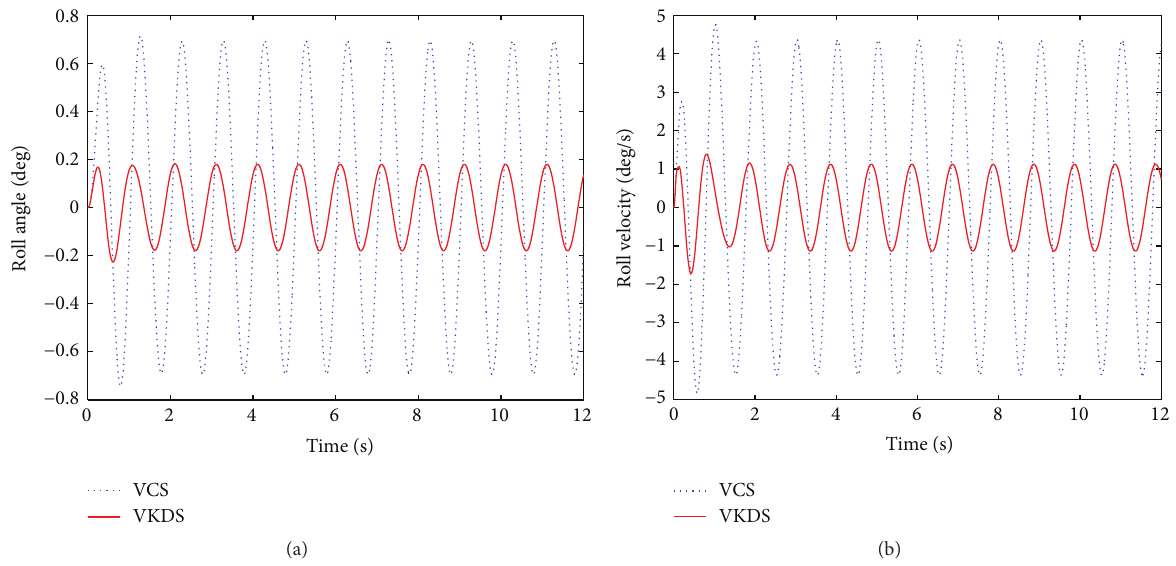
Figure 12: (a) Sprung mass roll angle of the VCS and VKDS under the warp mode excitation. (b) Sprung mass roll velocity.